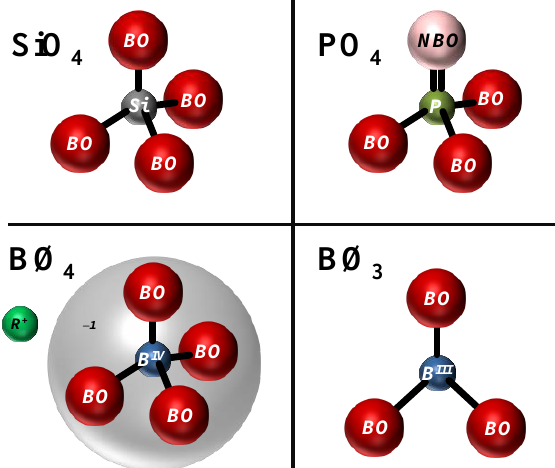
Figure 2. Schematic representation of structural units that build up an oxide glass network ( R stands for a generic network modifier cation; Ø corresponding to BO atoms).